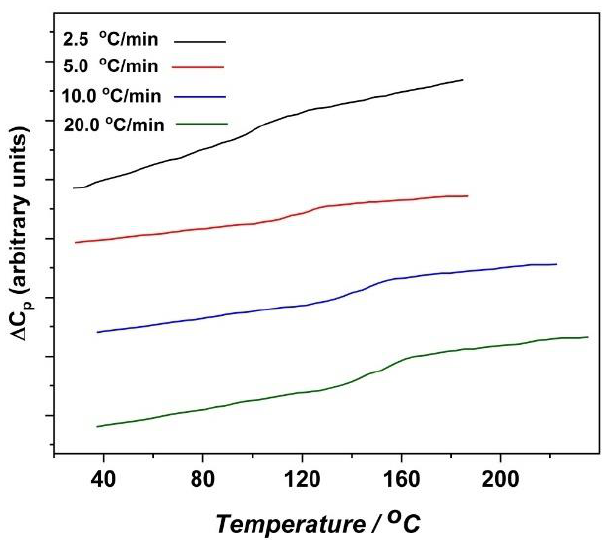
Figure 4. DSC thermograms of the Ter-III terpolymer sample obtained from the second. heating run at four different heating rates.